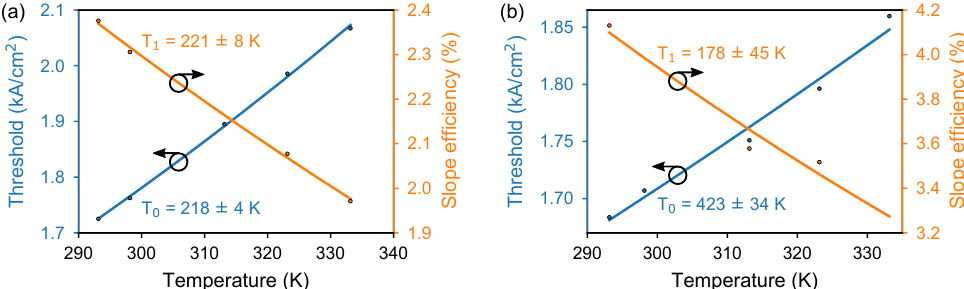
Figure 6. Current density at threshold (in orange) and slope efficiency (in blue) extracted as a function of temperature for ( a ) DFB and ( b ) DBR lasers.